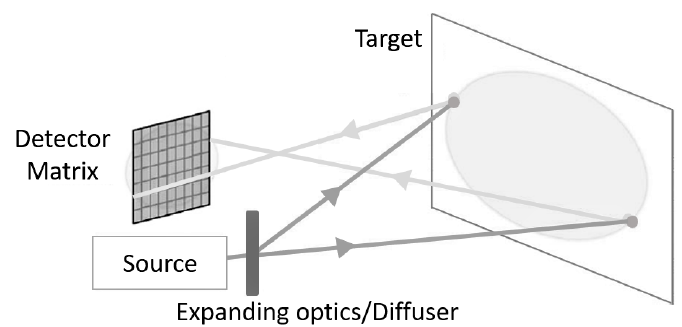
Figure 8. Detector array-based lidar